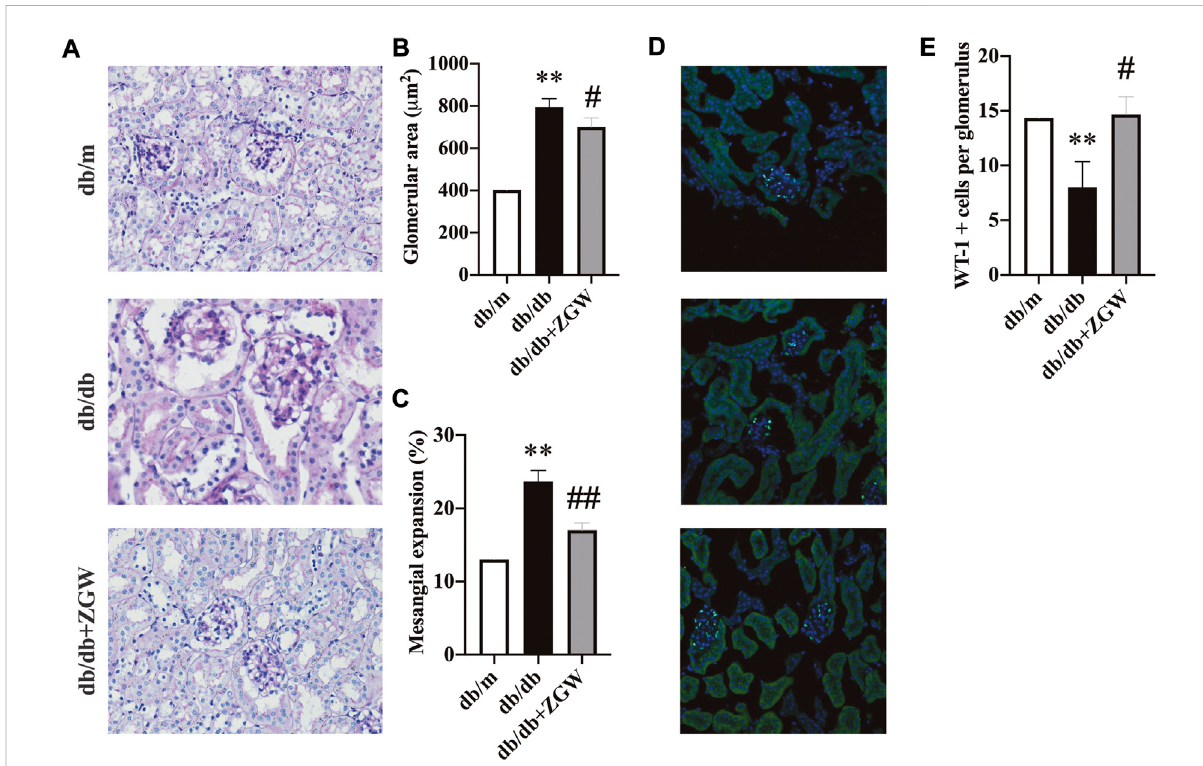
FIGURE 3 ZGW ameliorated renal histopathology in diabetic db/db mice. (A) Pathological changes of the kidney in different groups observed by PAS staining. (B) Glomerular size. (C) Mesangial expansion. (D) Immuno fl uorescence analysis of Wilms ’ tumor suppressor gene 1 (WT-1). (E) Quanti fi cation of WT-1-positive podocyte number per glomerulus. Magni fi cation: x200 in A and D. The results are expressed as the mean ± SD. Statistical analysis was performed with one-way ANOVA and the Newman – Keuls multiple comparison test. ** p < 0.01, compared with db/m mice. # p < 0.05, ## p < 0.01 compared with db/db